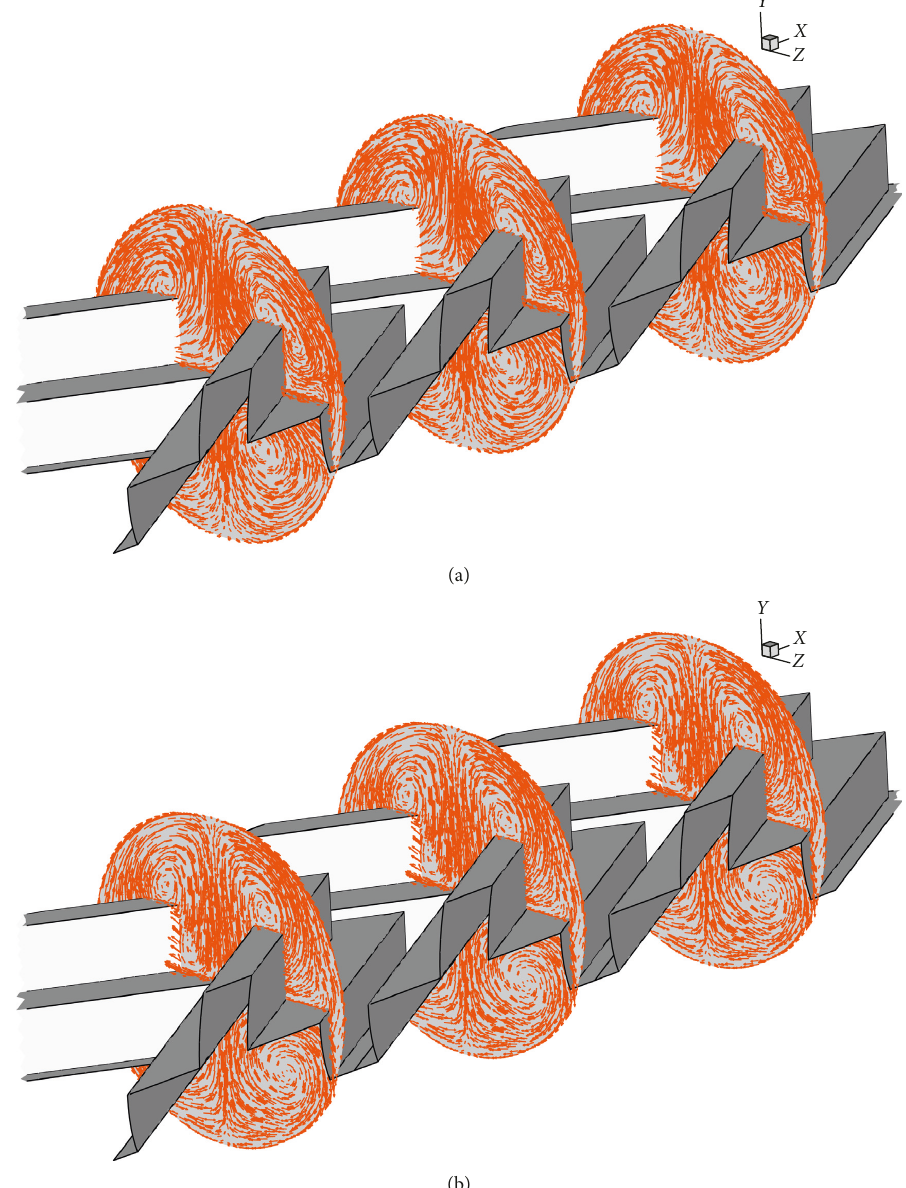
Figure 16: Tangential velocity vector in transverse planes of the heat exchanger tube inserted with the V-wavy surface at α 6000 for (a) V-Downstream and (b)